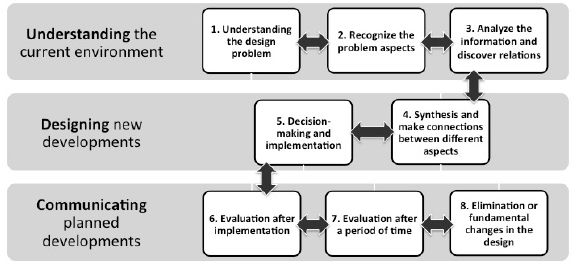
Figure 5. Conceptual design process from Parsaee et al.